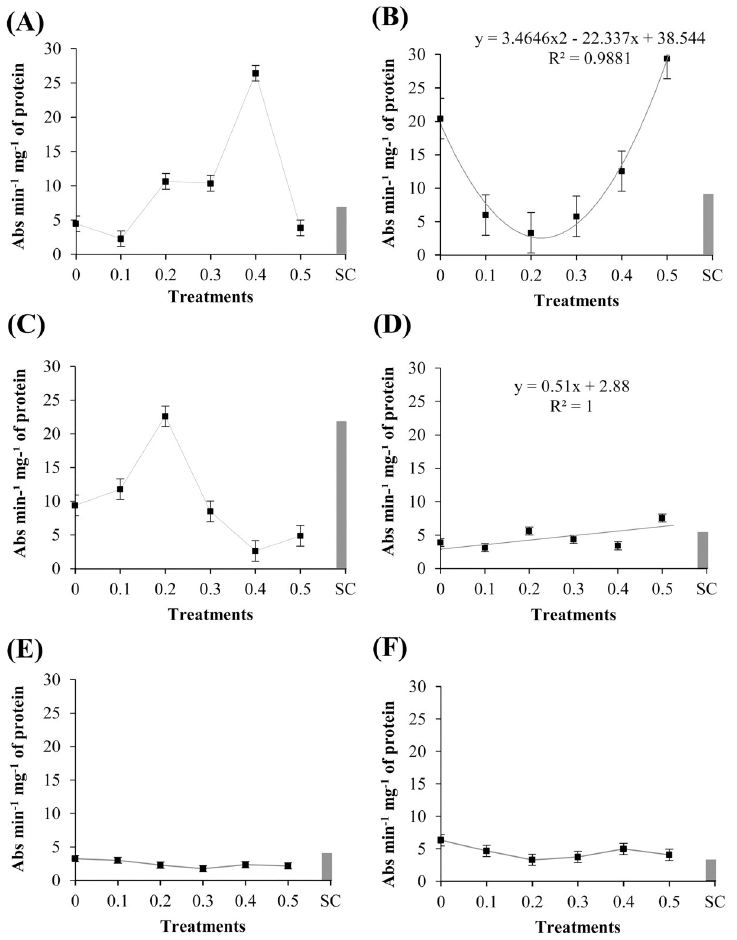
Fig 3. Specific activity of peroxidases in ‘Monsoy 8372 IPRO,’ ‘TMG 132 RR,’ and nontransgenic ‘TMG 4182’ treated with different concentrations of R . guttatus and R . marina (0.1, 0.2, 0.3, 0.4, and 0.5 mg/mL), sterile water (0), and S . cerevisiae (SC). Cultivars treated with R . guttatus cutaneous secretions (species 1): ( A ) ‘Monsoy 8372 IPRO’; ( B ) ‘TMG 132 RR’; and ( C ) nontransgenic ‘TMG 4182’. Cultivars treated with R . marina cutaneous secretions (species 2): ( D ) ‘Monsoy 8372 IPRO’; ( E ) ‘TMG 132 RR’; and ( F ) nontransgenic ‘TMG 4182’. Data are the mean of the three independent experiments. Data when significant were subjected to regression analysis (P � 0.05), adjusting the regression equations (R 2 ). Treatment with S . cerevisiae was used as an additional control. Metric bars indicate the standard error of the mean (SE).